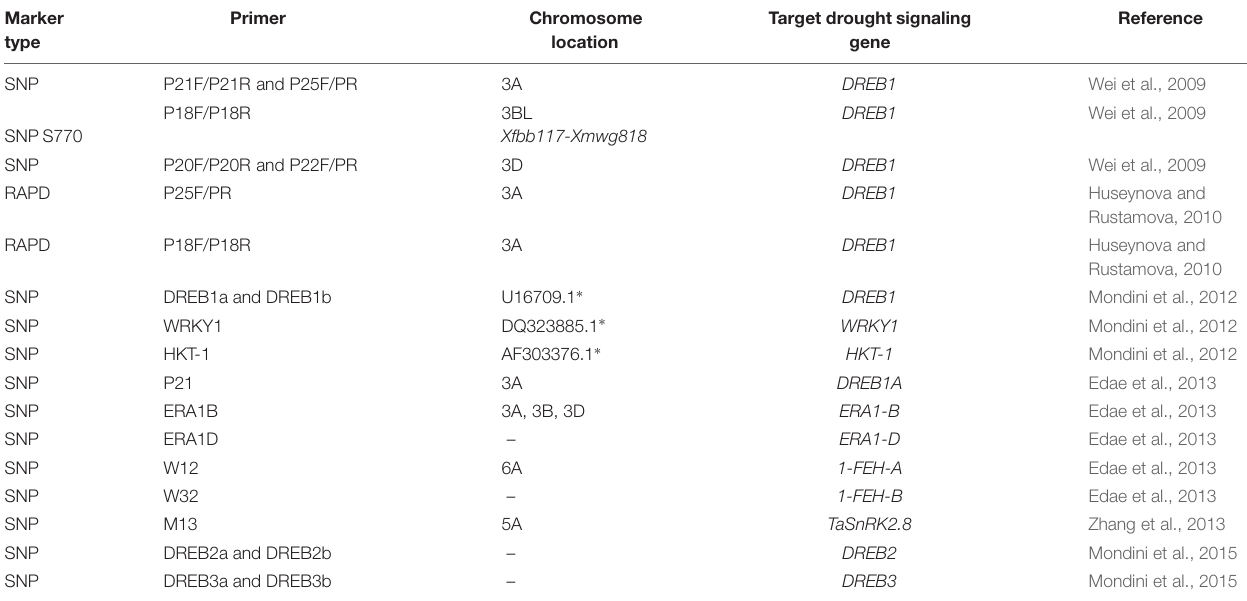
TABLE 1 | Molecular markers identified for wheat drought signaling genes.